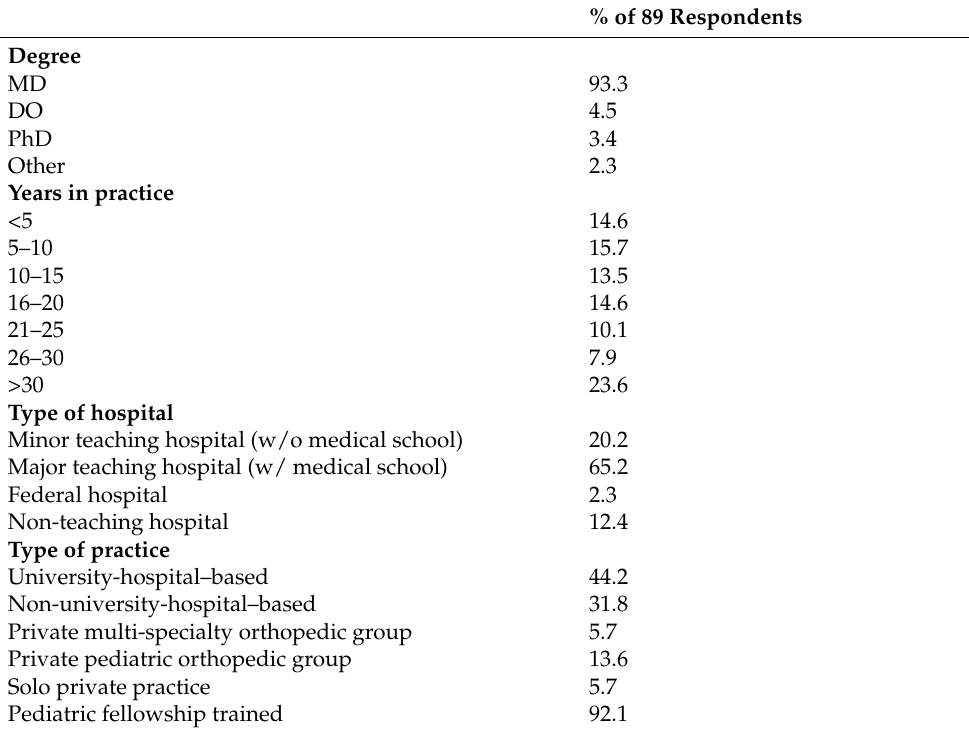
Table 1. Demographic characteristics of clubfoot providers.